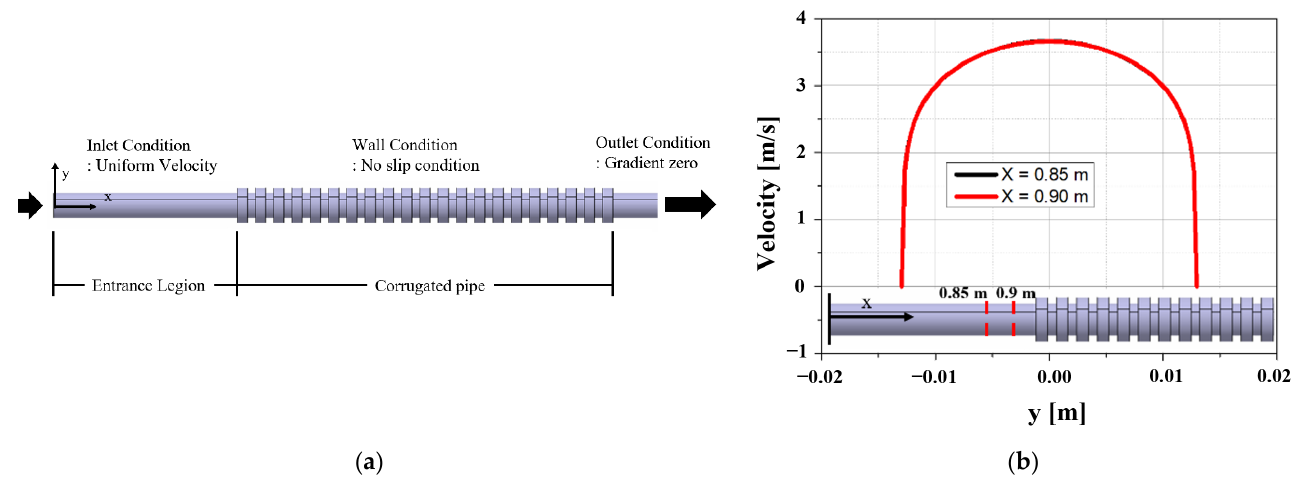
Figure 2. The boundary condition for numerical analysis, and Velocity distributions for fully developed flow. ( a ) Computa- tional domain and Boundary conditions, ( b ) Validation of fully developed flow.